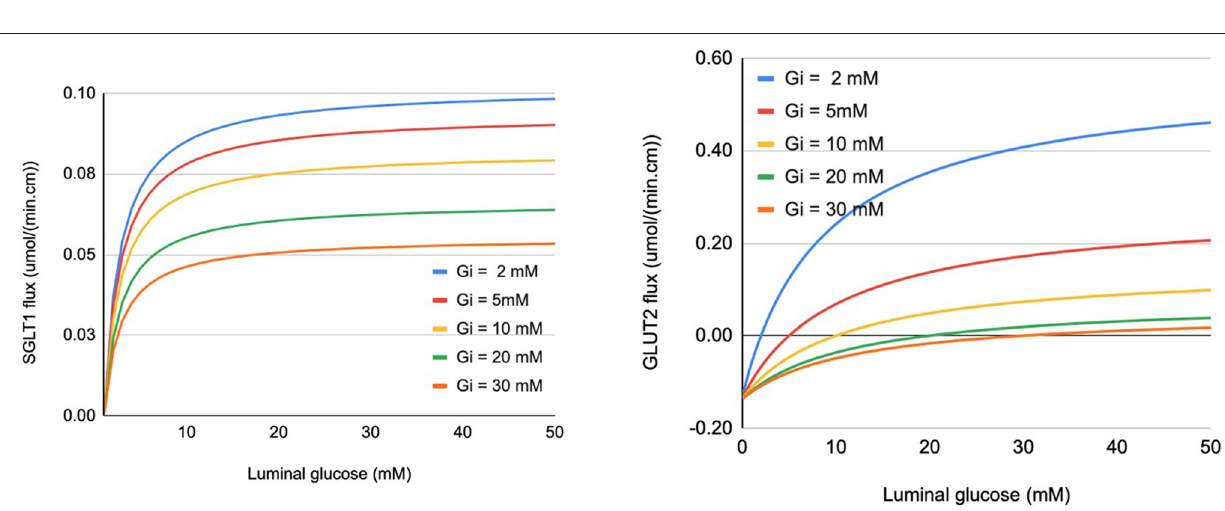
Frontiers in Physiology |